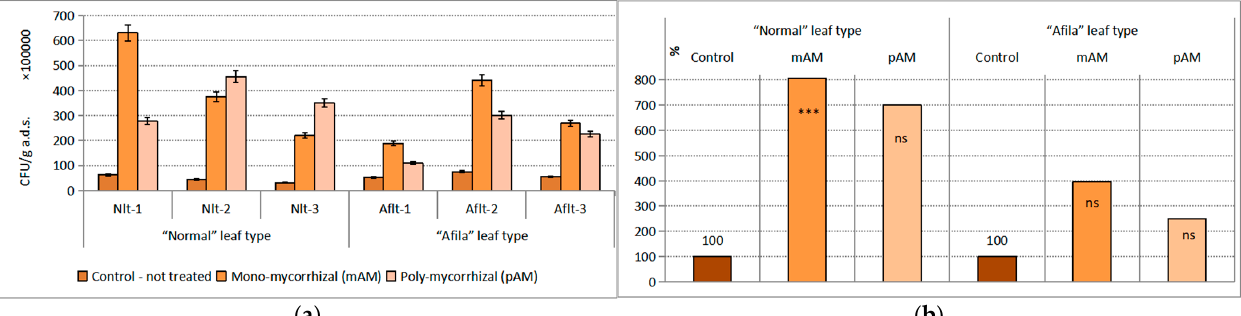
Figure 5. Average population density of the trophic group Phosphate-solubilizing bacteria (PSB) (CFU ∙ g − 1 absolutely dry soil) in the rhizosphere communities formed after introduction of AM fungi: (mAM) mono-mycorrhizal and (pAM) poly-mycorrhizal inoculants. ( a ) Average values for the particular varieties of garden pea with “normal” leaf type (Nlt-1—cvr. Marsi, Nlt-2—cvr. Plovdiv and Nlt-3—cvr. 22/16-n) and “afila” leaf type (Aflt-1—cvr. Marsi, Aflt-2—cvr. Plovdiv and Aflt-3—cvr. 22/16-af). Error bars indicate standard error of the mean (SE). ( b ) Relative values of the differences in the population levels of the trophic group Phosphate-solubilizing bacteria (PSB) (%) compared to the untreated controls, including means for both “normal” leaf type and “afila” leaf type genotypes. The significance of the differences between means of controls and treatments were calculated with the two-tailed Student’s t -test (at df—10; *** p < 0.01, ns—nonsignificant).